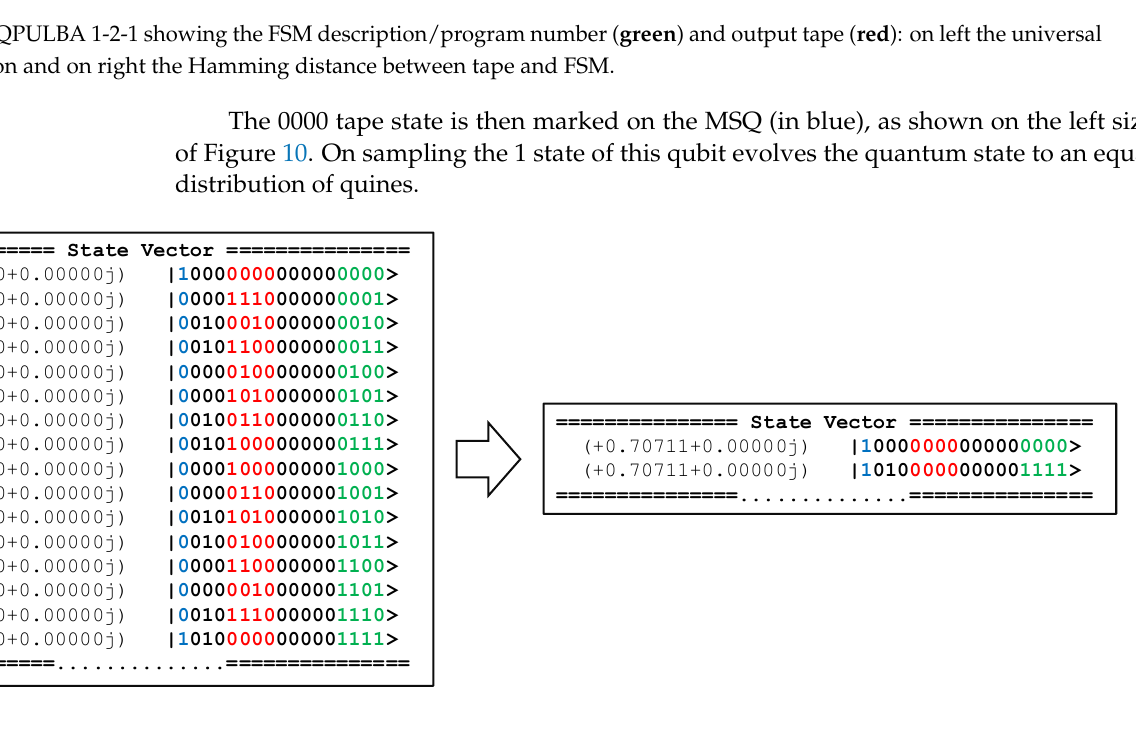
Figure 10. Sampled distribution of